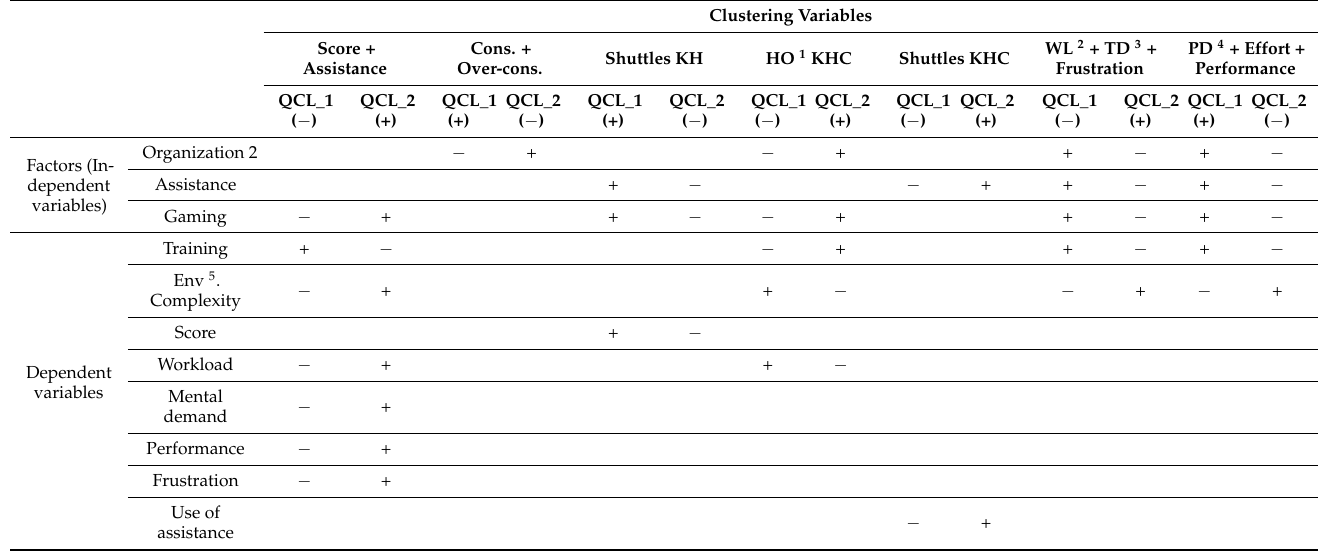
Table 11. Summary of the results